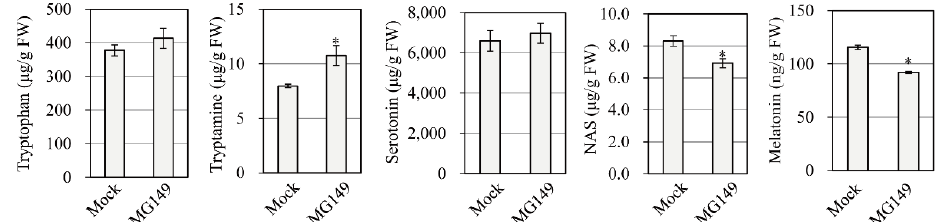
Figure 4. Quantification of melatonin and its precursors in rice seedlings. The 7-day-old rice seed- lings were rhizosperically treated with 100 μM MG149 plus 0.5 mM cadmium for melatonin induction for 3 days. The mock contained 0.1% ethanol. Asterisks (*) indicate significant differences from the mock control (Tukey’s HSD; p < 0.05).